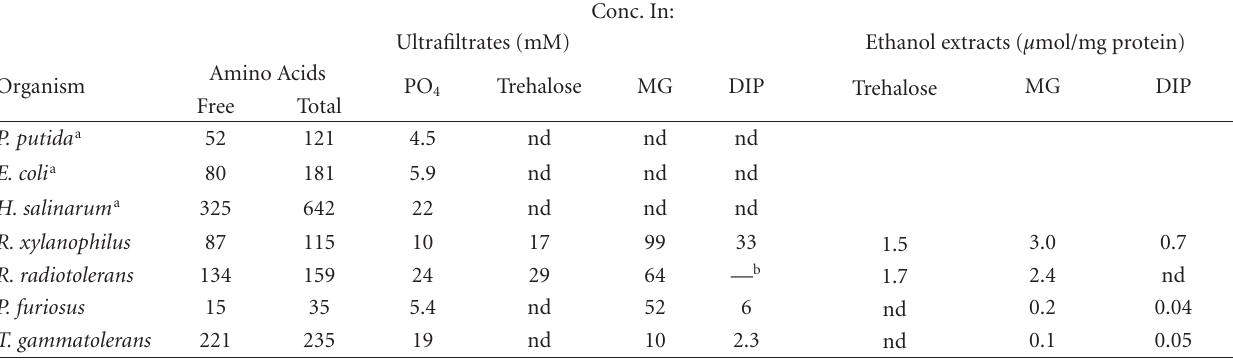
a Dose at which viable cells are reduced to 10% of the population. b From [11]. Table 2: Concentrations of amino acids, PO 4 , and compatible solutes in thermophiles and radiation-sensitive bacteria UFs and thermophiles ethanol extracts. Conc. In: Ultrafiltrates (mM) Ethanol extracts ( µ mol/mg protein) Amino Organism